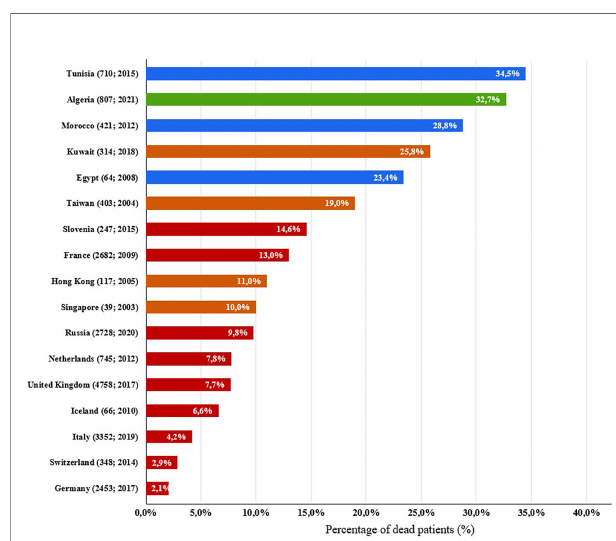
FIGURE 7 | Comparison of IEI death percentages in our cohort with previously published IEI studies of other countries. Algeria: green; European countries: red; Asian countries and regions: brown, north African countries: blue. Parentheses next to each country name correspond to number of patients followed by year of analysis (number of patients; year of